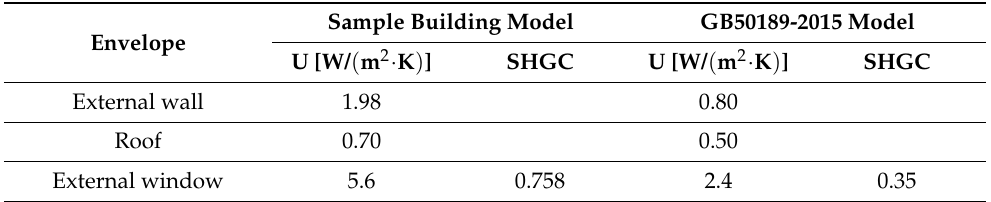
Table 4. Thermal properties of the sample building and GB50189-2015 model.